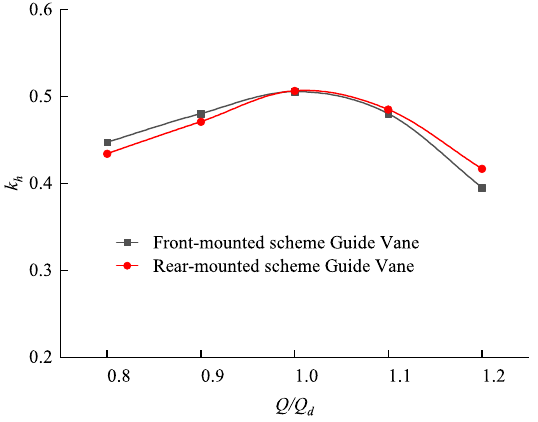
Figure 10. Kinetic energy recovery coefficient of the guide